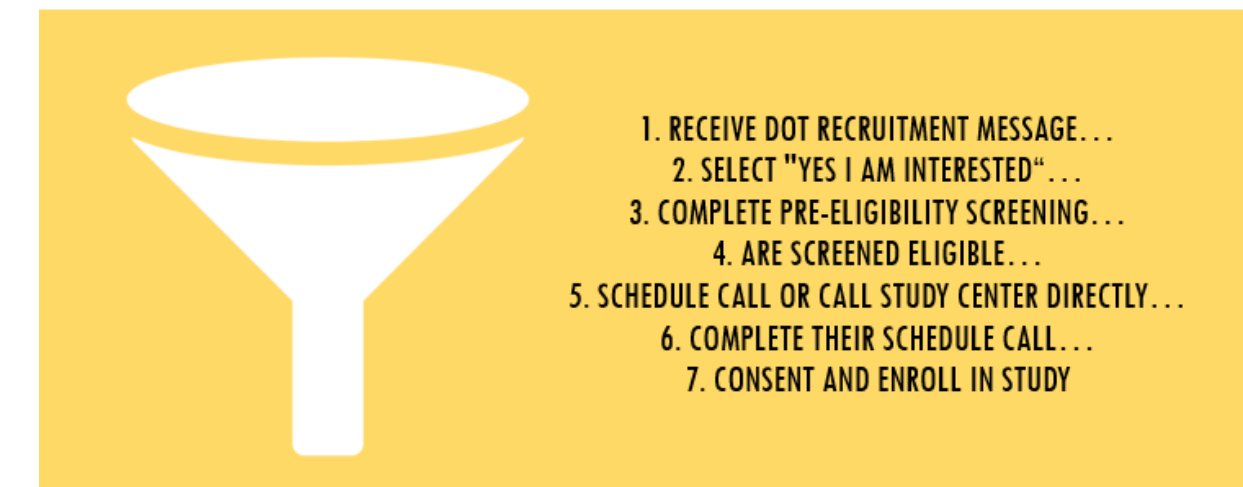
Figure 4. Dot study recruitment and enrollment process